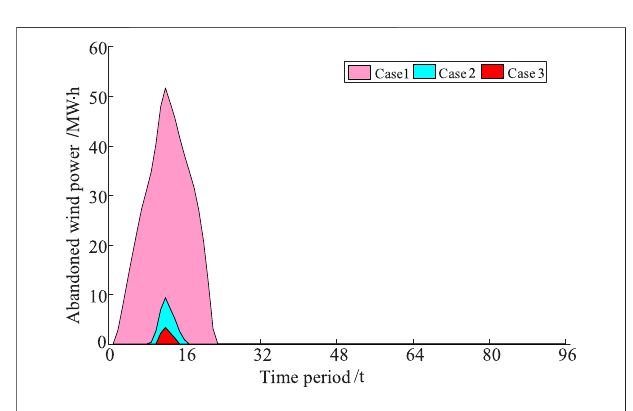
FIGURE 11 | Abandoned wind power.